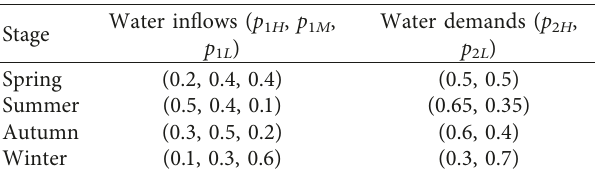
Table 10: Probabilistic distributions of water inflows and demands in each seasonal stage.